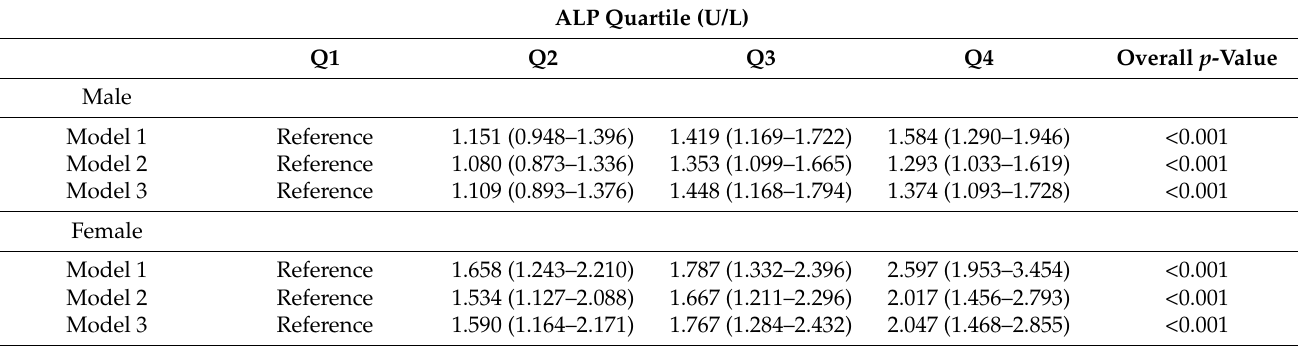
Table 3. Odds ratios and 95% confidence intervals for high TyG index according to serum ALP